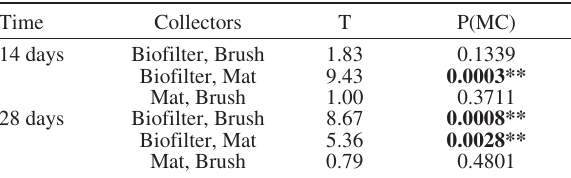
Table 4. – Pairwise comparisons for the significant interaction of the factors ‘Collector × Time’ obtained in the permutational analysis of variance (PERMANOVA) assessing differences in number of A. lixula settlers collected at Abades in February 2012. Differences in settler abundances between the three types of artificial collectors tested at the different sampling times are given. Significant results are shown in bold (** p<0.01).